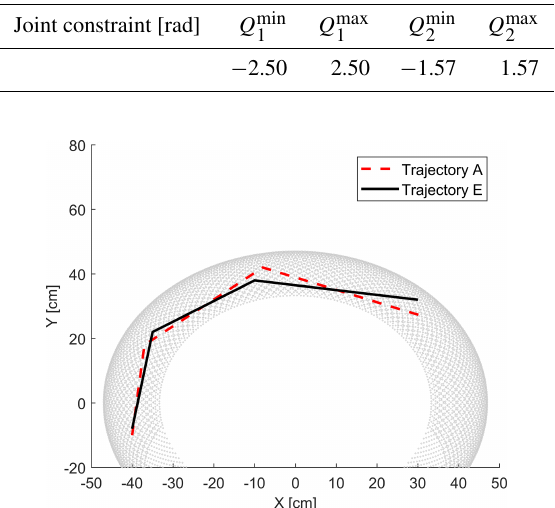
Table 1. TT-3000 hard constraints for the computer simulation.